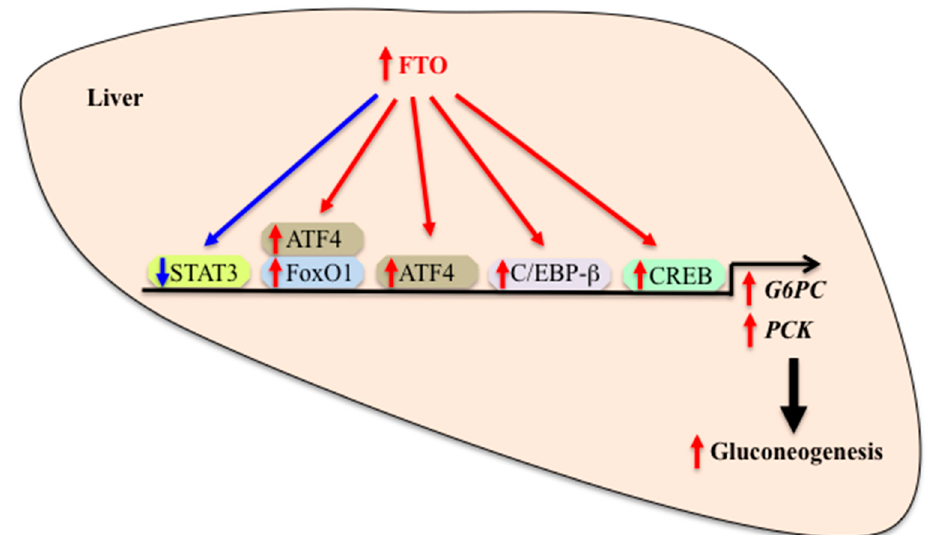
Figure 2. Role of FTO in the regulation of hepatic gluconeogenesis. FTO regulates hepatic gluconeogenic gene expression by altering the activity of and interaction with transcription factors. Increased FTO expression and/or activity causes an increased transcription of genes encoding gluconeogenic enzymes, leading to an increased gluconeogenesis, while reduced FTO expression and/or activity causes the opposite effect. FTO: Fat mass and obesity-associated, G6PC: Glucose-6-phosphatase, PCK: Phosphoenolpyruvate carboxykinase, STAT3: Signal transducers and activators of transcription 3, CREB: cAMP responsive element binding protein, C/EBP- β : CCAAT/enhancer-binding protein-beta, ATF4: Activating transcription factor 4, FoxO1: Forkhead box protein O1. Red arrow: Stimulation. Blue arrow: Inhibition.